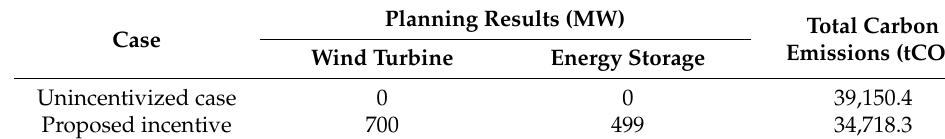
Table 6. Planning results with no incentive and with the proposed incentive.